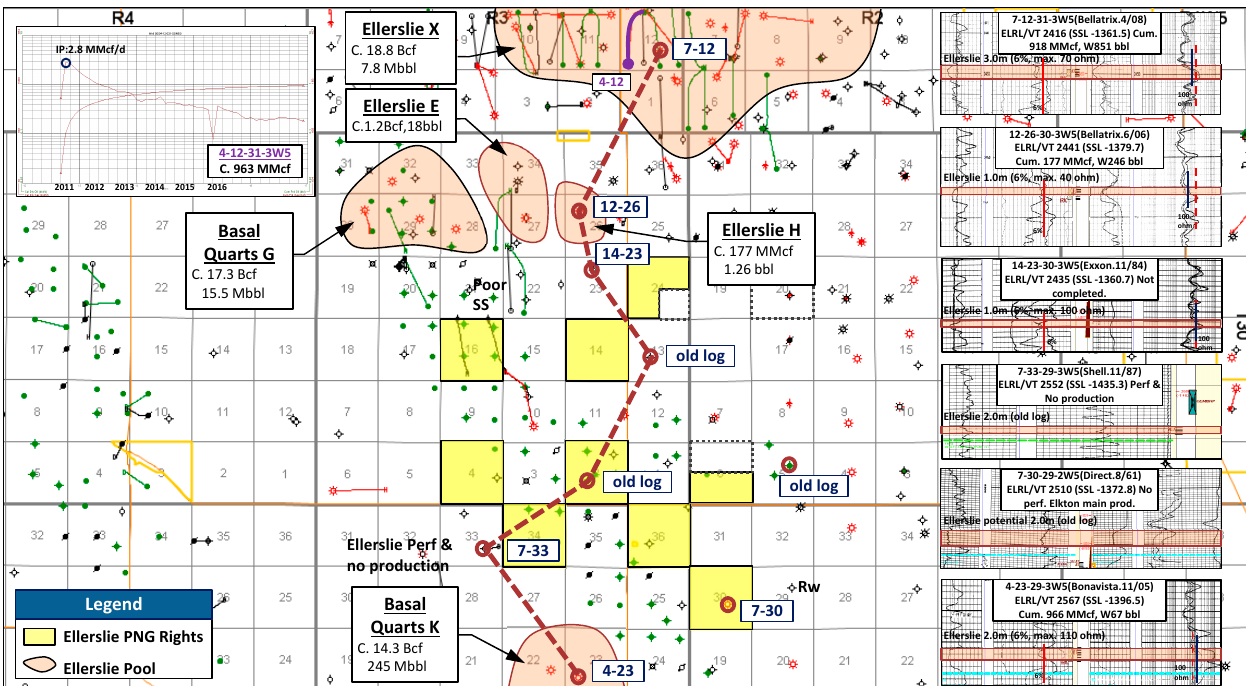
Figure 10. Ellerslie development potential in the study area.